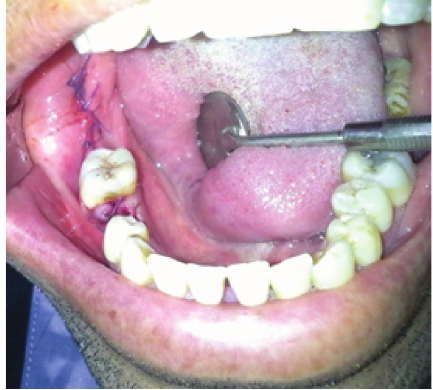
Figure 2: Intraoperative view after extraction of the mandibular right second premolar and debridement of the mandibular right third molar